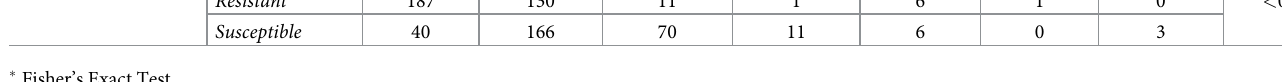
Table 2. Combined occurrences of V1016I and F1534C genotypes compared to pyrethroid-resistant phenotype. Fisher’s tests indicated significant associations between genotypes and phenotypes for resistance. V1016I /